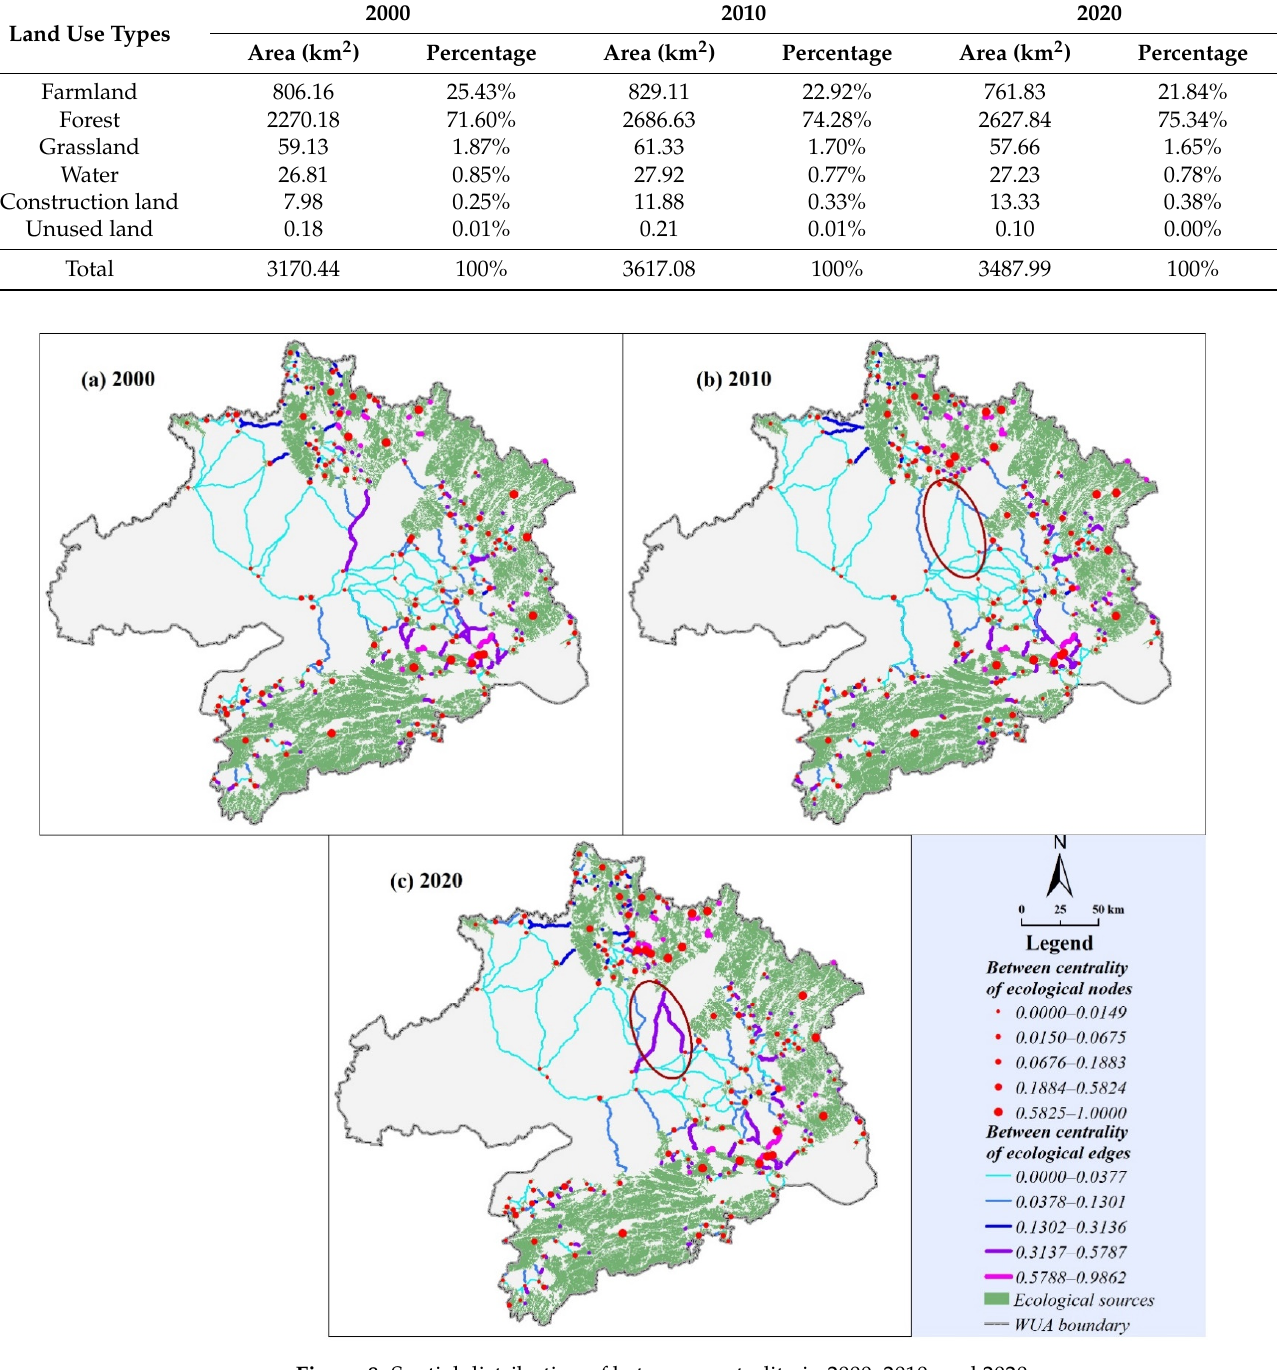
Figure 8. Spatial distribution of between centrality in 2000, 2010, and 2020.